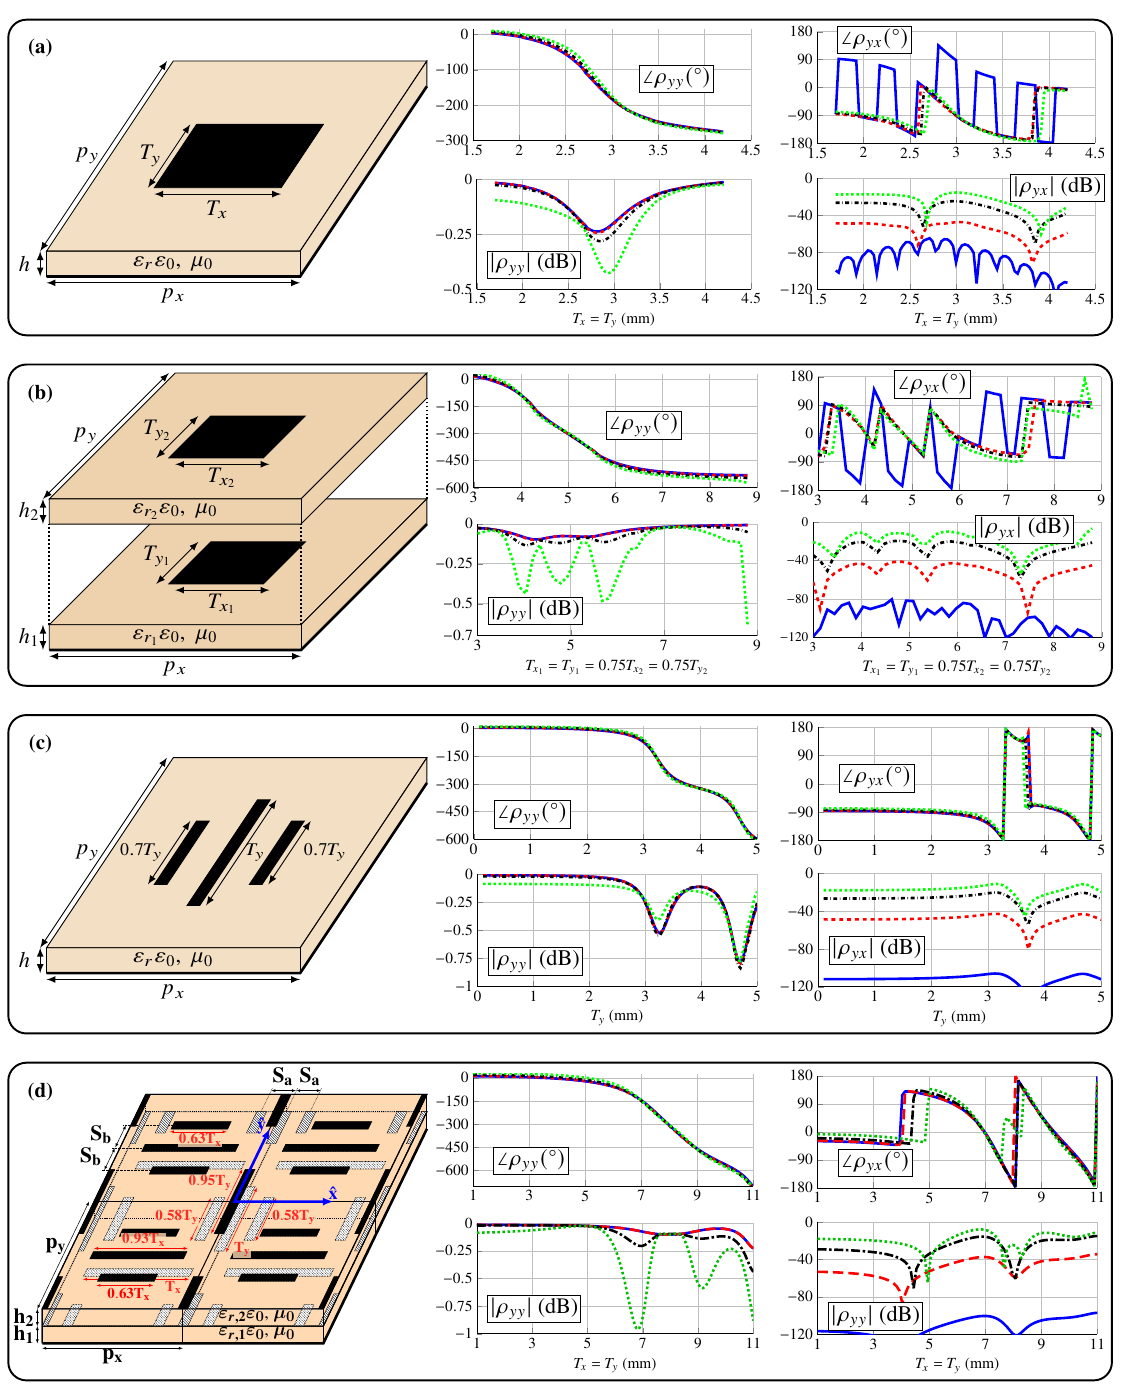
Figure 3. Electromagnetic response of several unit cells for the direct coefficient ρ yy and the cross-coefficient ρ yx : ( a ) single patch; ( b ) two stacked patches; ( c ) three parallel dipoles orientated in the ˆ y axis; and ( d ) two sets of four parallel dipoles shifted half a period from each other ( S a = S b = 3.9mm and dipole widths of 0.5mm). The results are for oblique incidence at ( θ = 1°, ϕ = 1° ) (blue solid line), ( θ = 10°, ϕ = 15° ) (red dashed line), ( θ = 25°, ϕ = 40° ) (black dashed-dotted line) and ( θ = 40°, ϕ = 50° ) (green dotted line). Shared characteristics of the unit cells for the electromagnetic response shown here are described in Table 1. Some of these unit cells have been employed in other works for the design of reflectarray antennas. For instance, ( b ) is taken from [24], ( c ) from [25] and ( d ) from [26]. The results for a design using unit cell ( a ) are